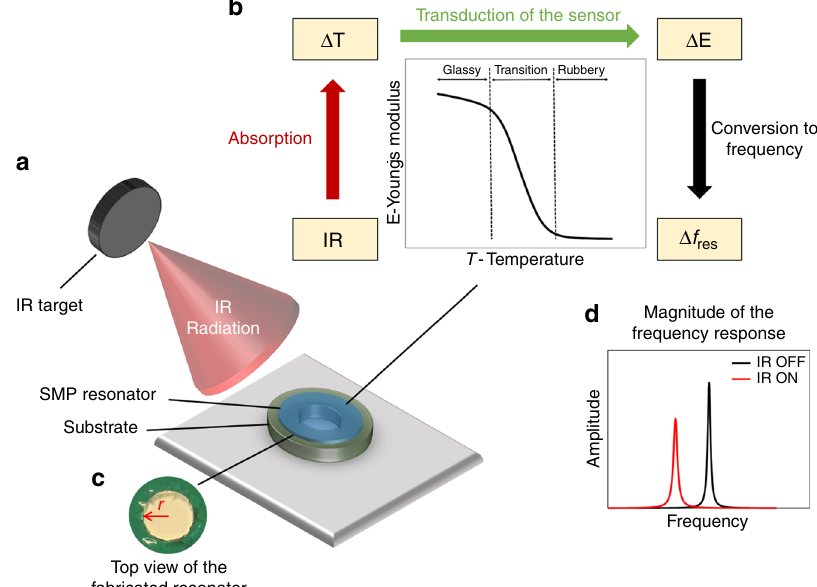
Fig. 1 Overview for the IR SMP resonant sensor and the working principle. a IR sensor system illustration. b The working principle of the IR SMP sensor: The incident IR radiation from the IR target causes a temperature change, Δ T, on the SMP resonator. This leads to a change in the Young ’ s modulus, Δ E, of the SMP material, which shifts the resonance frequency, Δ f res , of the SMP resonator. c Top view of the fabricated SMP resonator. d Schematic frequency response of the IR SMP resonator when the IR illumination is on and off: the change in the IR target ’ s temperature can be detected from the change in resonance